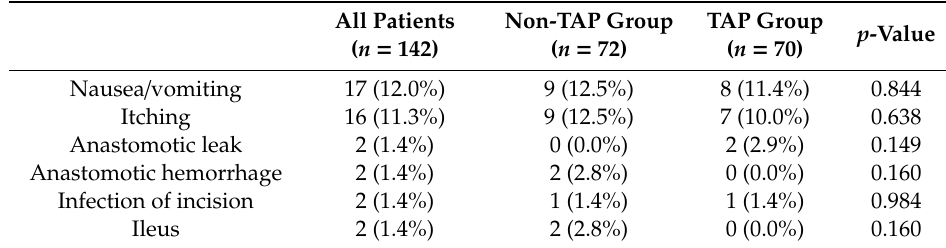
Table 5. Postoperative